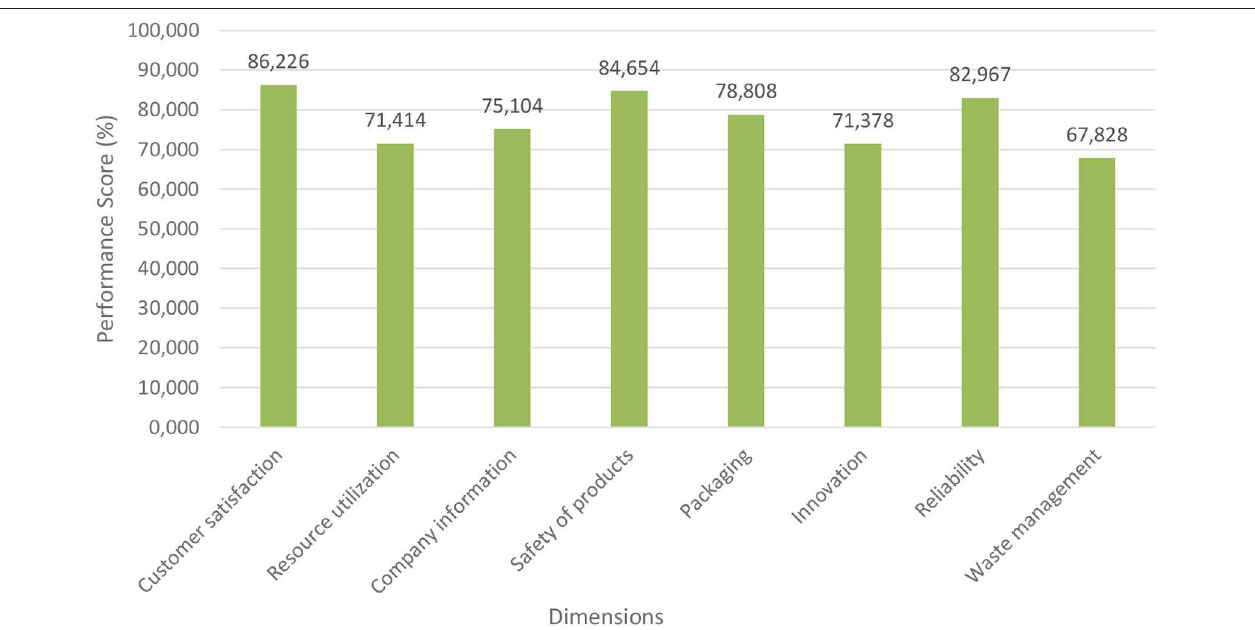
FIGURE 7 | Distribution of performance index scores for SFSCM dimensions.